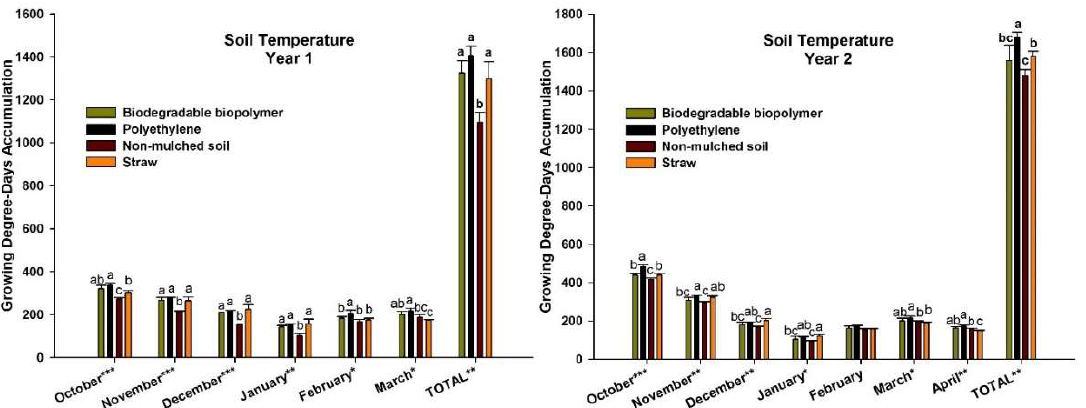
Figure 3. Monthly and Total Growing Degree-Days Accumulation in the two crop seasons depending on mulch type and for non-mulched soil. Values (mean ± standard deviation; n = 3). Different letters in the same period indicate significant differences ( p ≤ 0.05, Fisher ´ s LSD test). ‘*’, ‘**’, and ‘***’ indicate significance at p ≤ 0.05, 0.01, and 0.001, respectively.